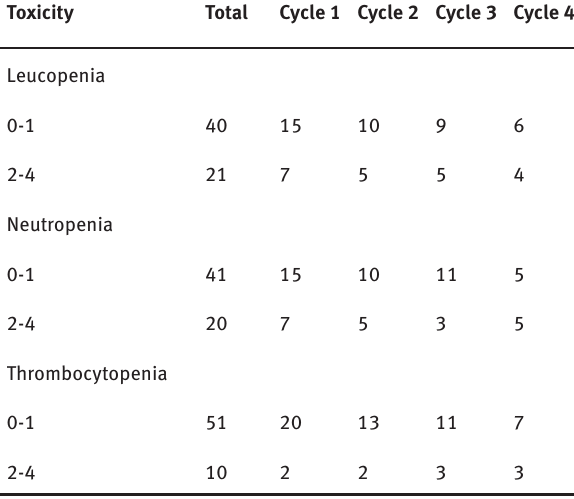
Table 2: The number of pemetrexed related toxicities per chemotherapy cycle.